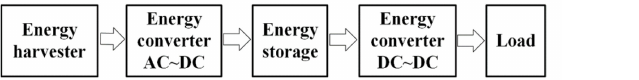
Figure 2. The energy storage module as the intermediate bus voltage in the EH system [16–18].